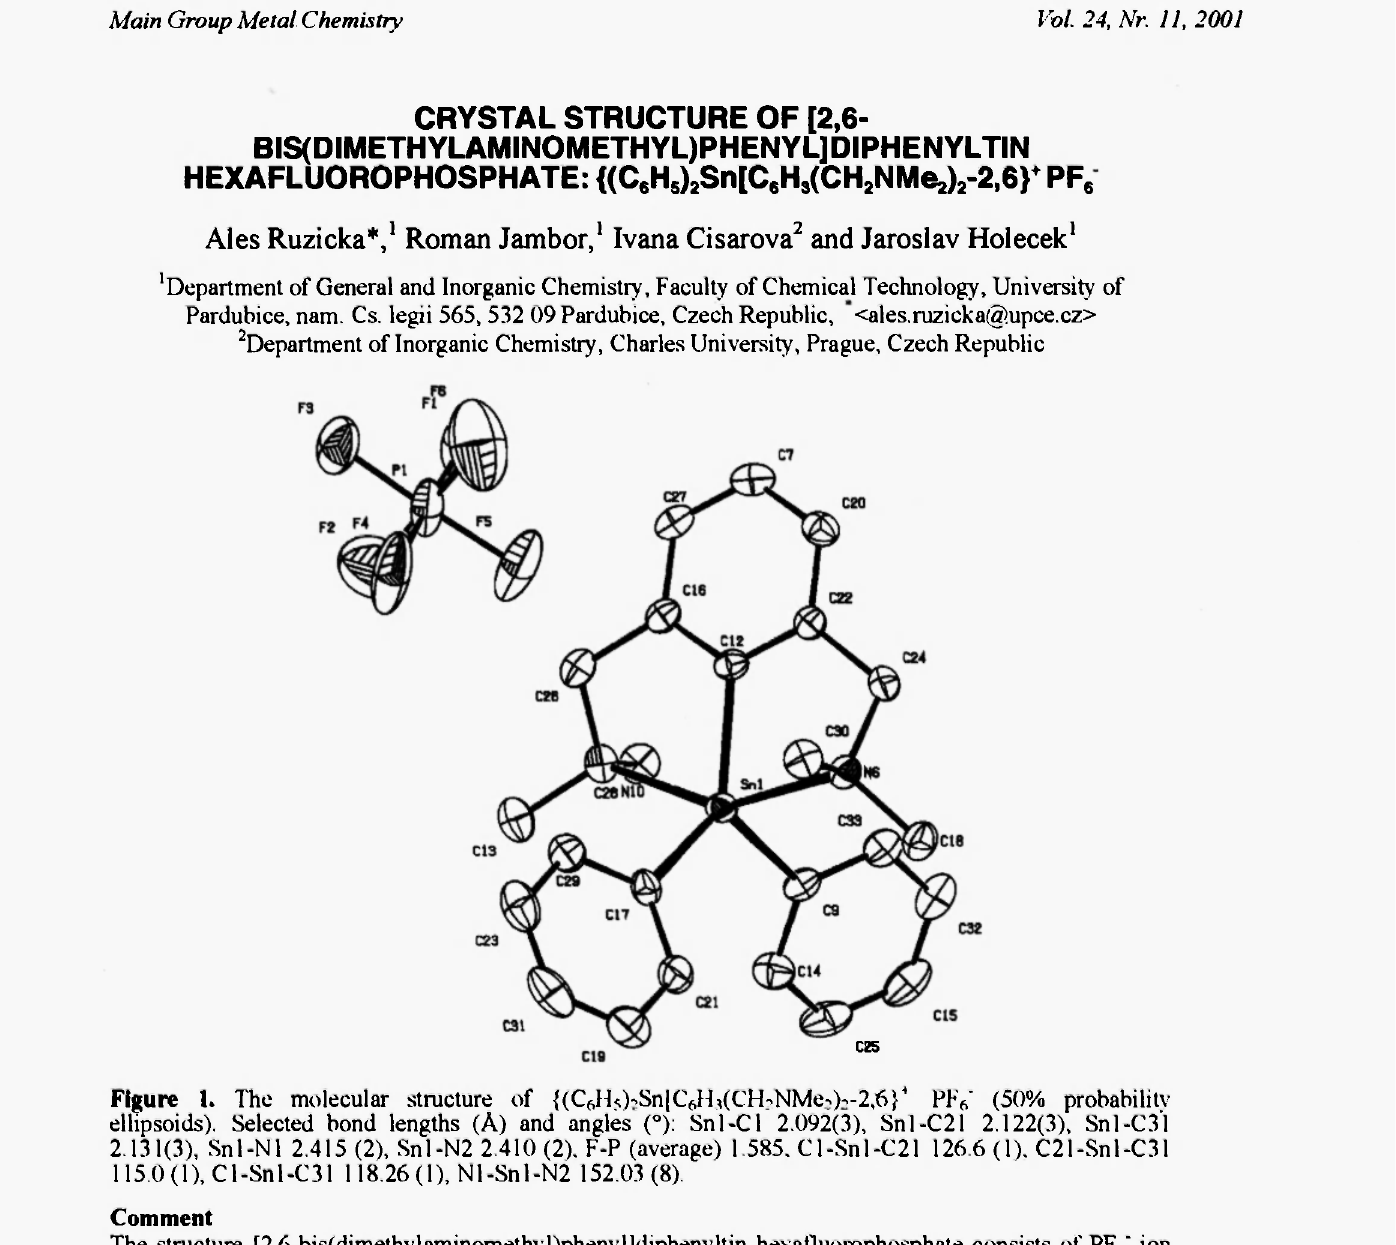
Figure 1. The molecular structure of {(C 6 H0-Sn|C ei H,(CH-.NMe-.),-2 < 6r PFV (50% probability ellipsoids). Selected bond lengths (A) and angles (°): Snl-Cl 2.092(3), Snl-C21 2.122(3), Snl-C3'l 2.131(3), Snl-Nl 2.415 (2), Snl-N2 2.410 (2). F-P (average) 1.585. Cl-Snl-C21 126.6 (1), C21-Snl-C31 115.0(1), Cl-Snl-C31 118.26 (1), Nl-Snl-N2